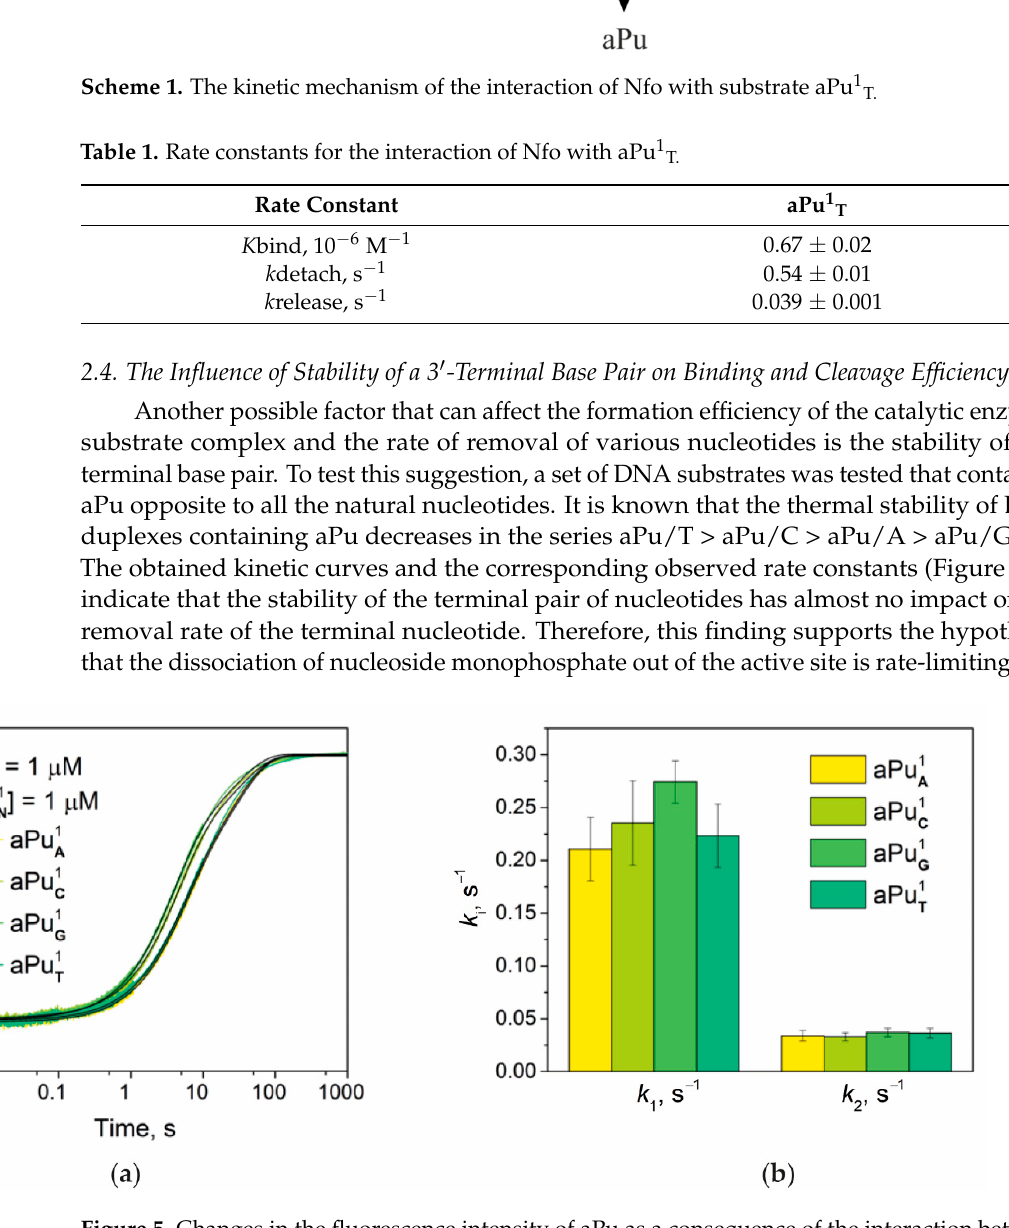
Figure 5. Changes in the fluorescence intensity of aPu as a consequence of the interaction between Nfo and aPu 1N ( a ). Observed rate constants k obs 1 ( b ). The data were fitted to the exponential function described by Equation (1) ( a ).